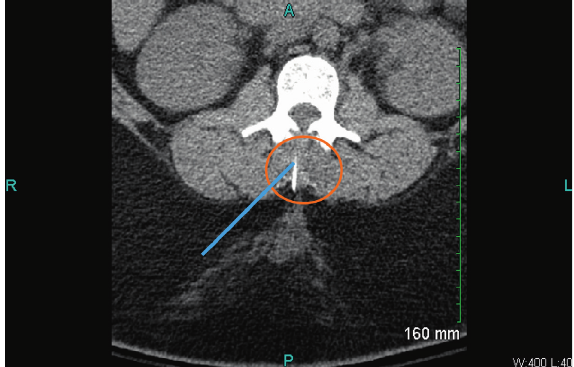
Figure 2: Computed tomography of lumbar